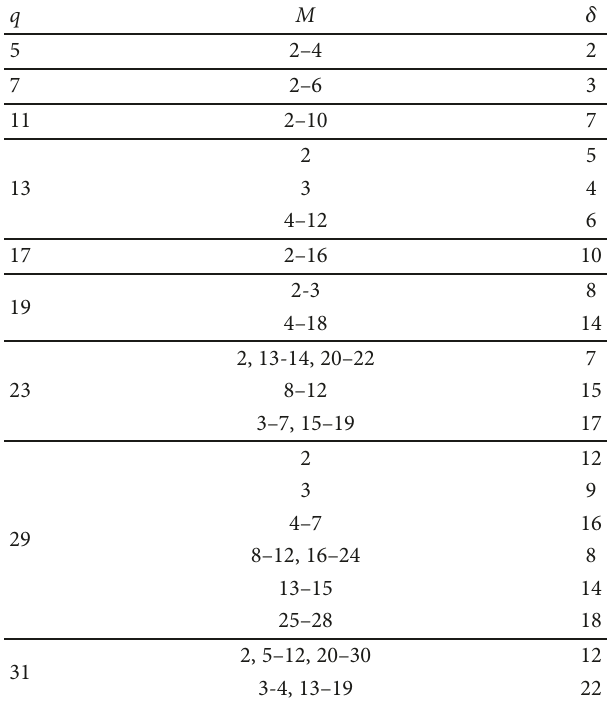
Table 1: The corresponding values of parameter δ for di ff erent values of q and M q